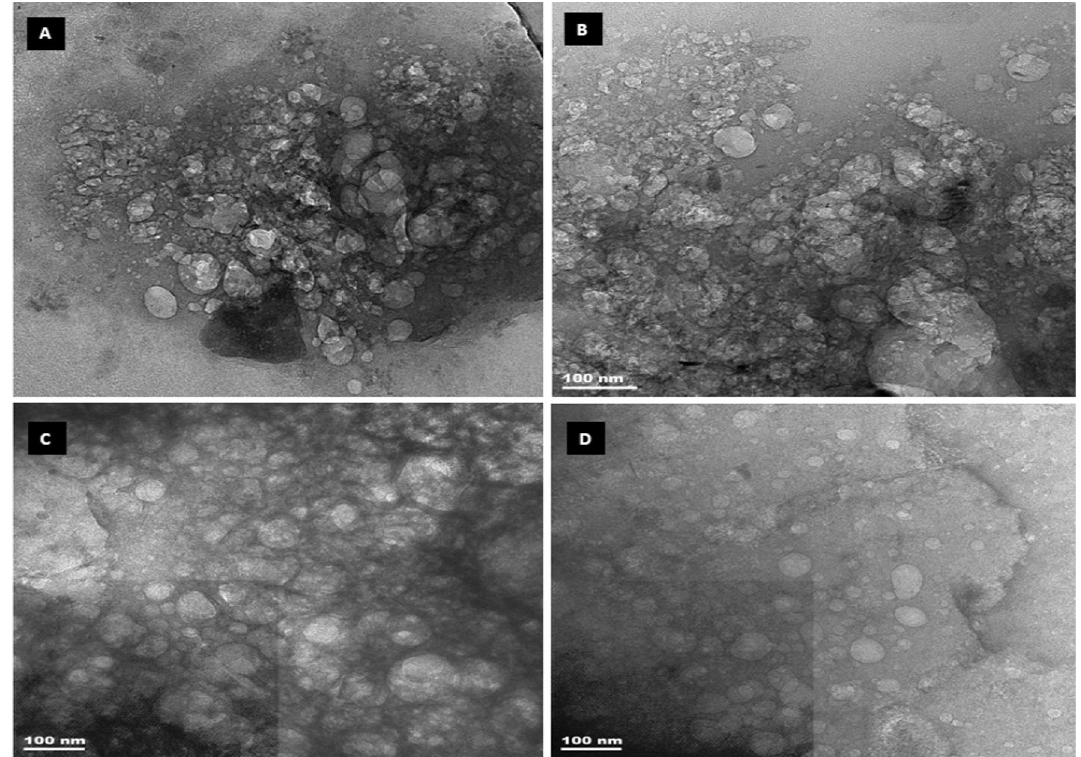
Fig. 3 The Cryo-TEM micrographs of A : Sesamum indicum oil based nanoemulsion (SOAB) B , C and D : Ciprofloxacin-loaded Sesamum indicum oil based nanoemulsion